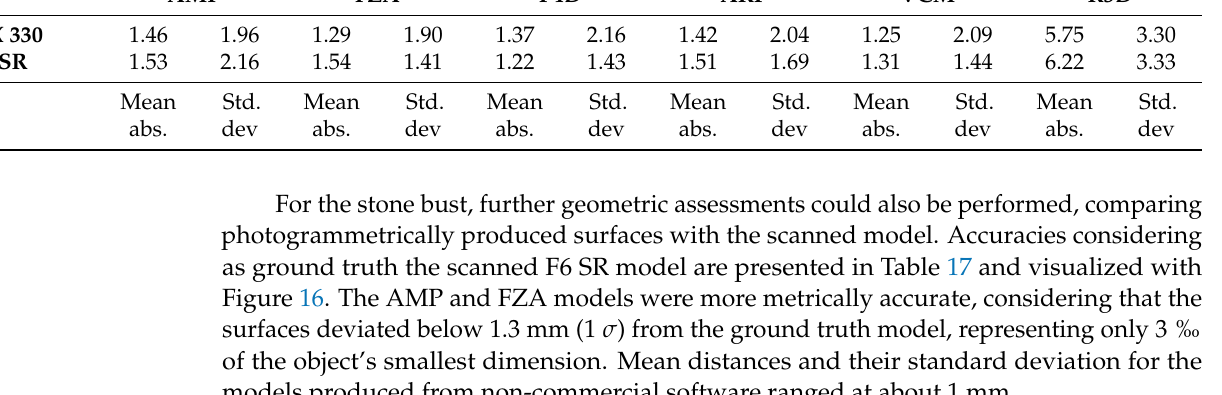
Table 16. Hausdorff distances between 3D scanning and photogrammetric models from dataset 5 (distances in mm). 3D X 330 1.46 1.96 1.29 1.90 F6 SR